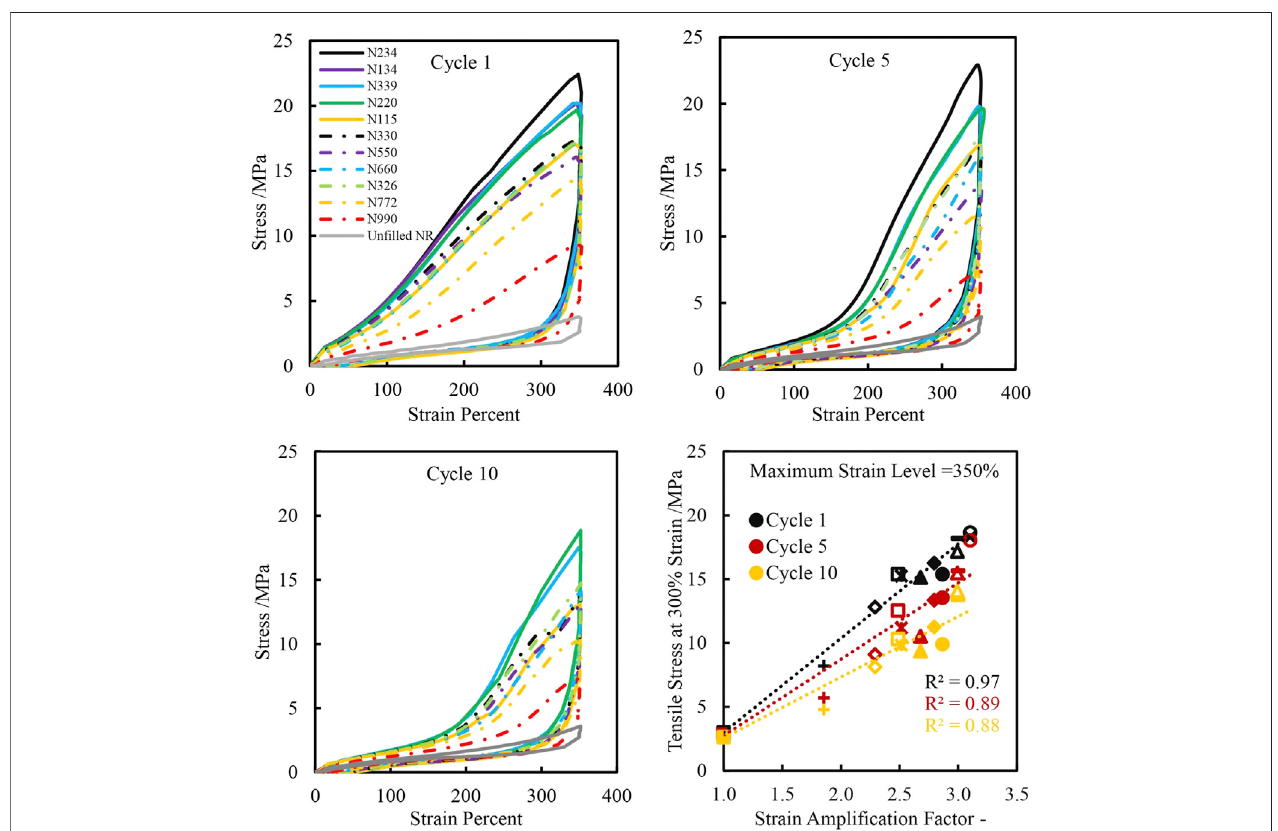
FIGURE 3 | Stress-strain plots of carbon black reinforced and unreinforced natural rubber extended to 350% strain and retracted after a 2 min hold on cycles 1, 5 and 10. Tensile stress at 300% strain as a function of strain ampli fi cation factor for cycles 1, 5 and 10.